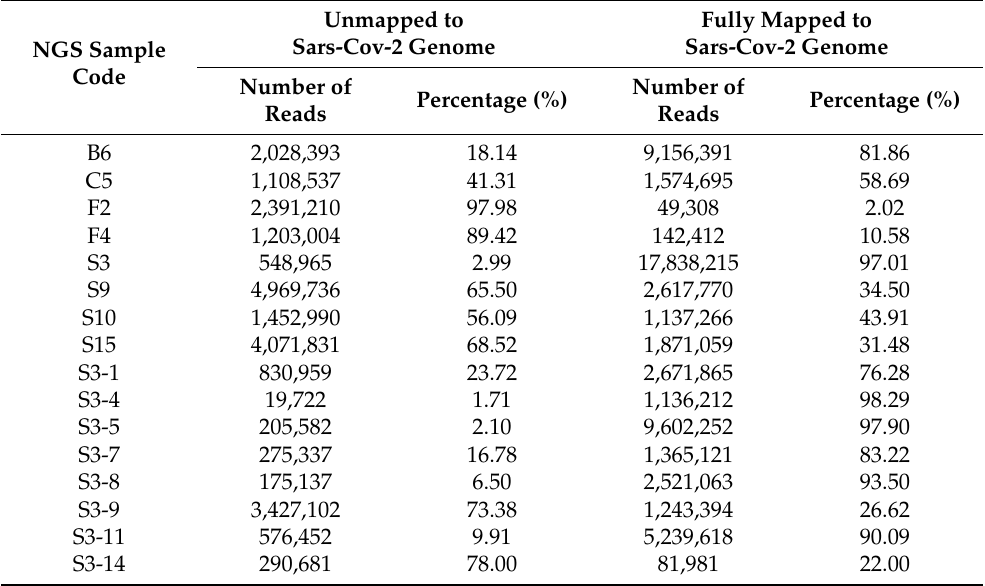
Table 4. The alignment statistics summary of unmapped and fully mapped reads in each sample’s